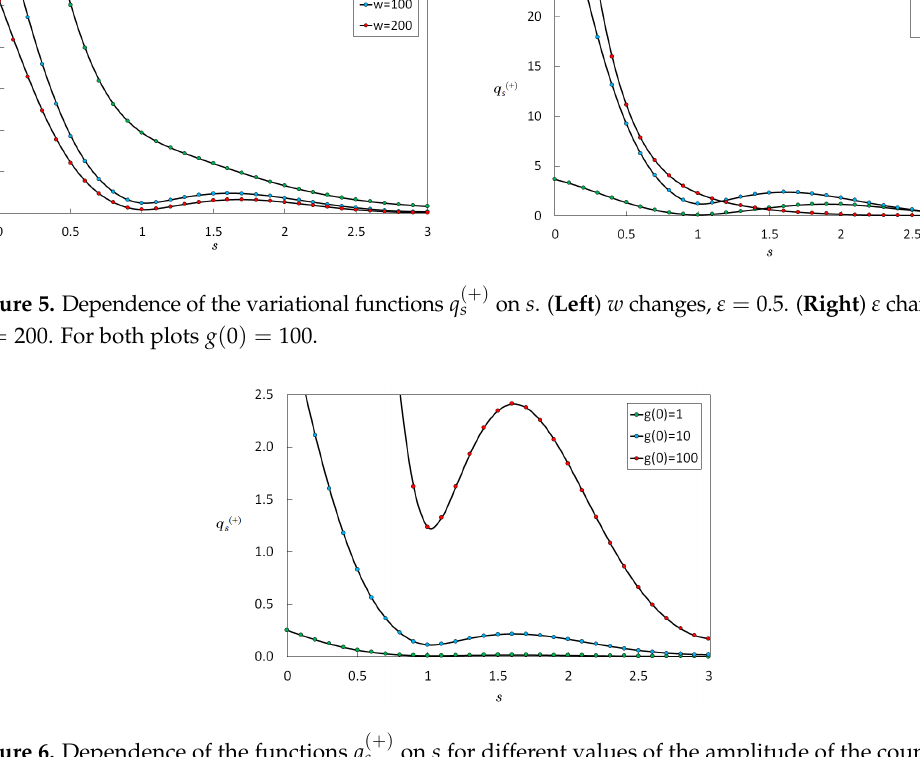
(+) Figure 6. Dependence of the functions q s on s for different values of the amplitude of the coupling constant g ( 0 ) . The parameters w and ε are fixed and equal to w = 200 and ε = 0.5, respectively.